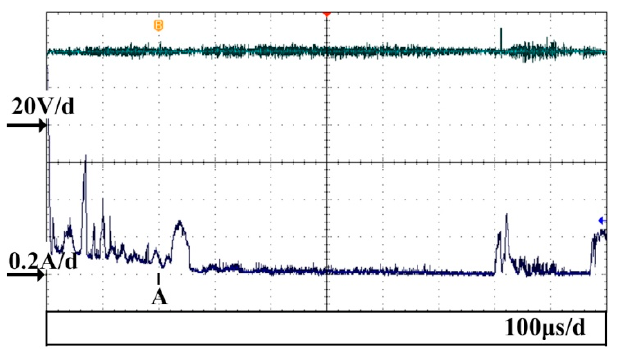
Figure 8. Voltage and current waveforms including a third type of discharge.